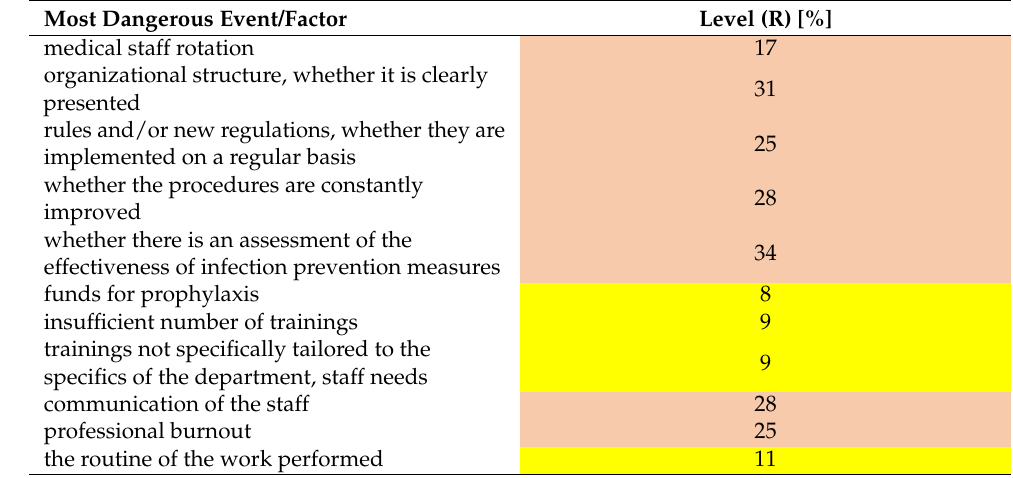
Table 10. Relative risk (R) for the gravest events/factors in the category of organizational and explicit factors resulting from direct contact with the patient.